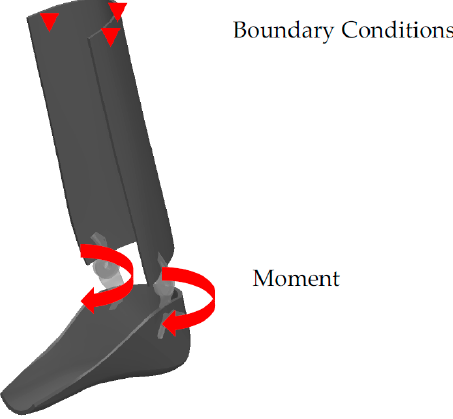
Figure 6. The 3D assembly of the AFO components and the applied moment and boundary conditions.